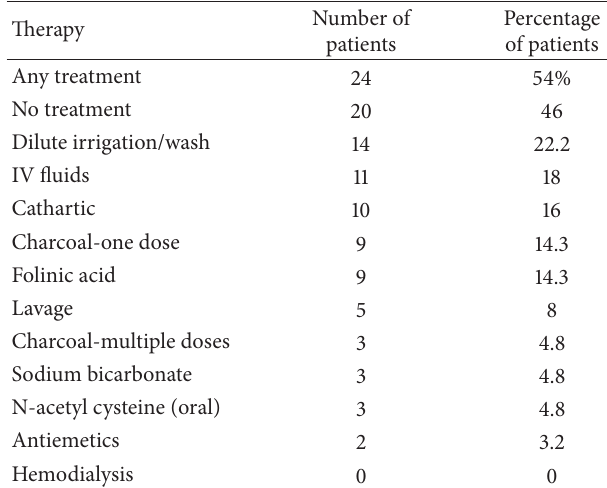
Table 2: Therapies reported for acute methotrexate ingestions in adults as reported to six poison centers ( 𝑁 = 44